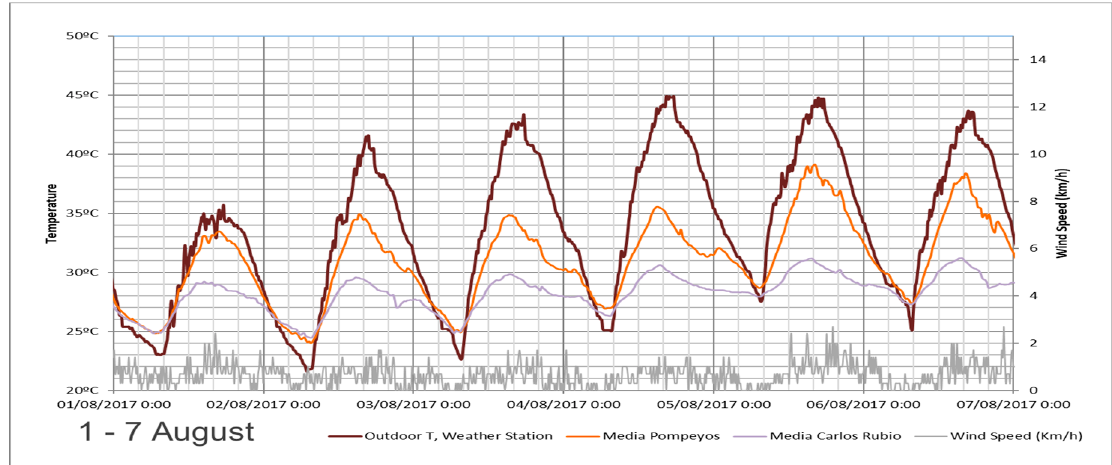
Figure 3. Air Temperatures and Wind Speed in courtyards and the outside from August 1st to 7th.